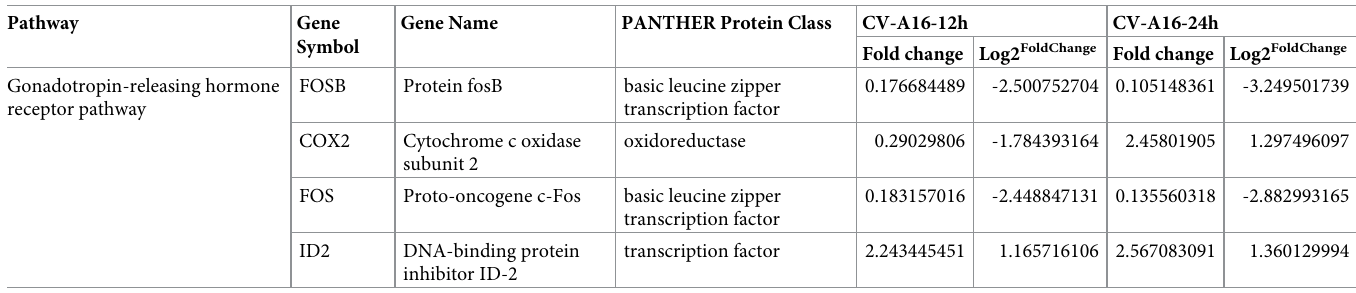
Table 3. Gonadotropin-releasing hormone receptor pathway-associated differentially expressed genes in KEGG pathway analysis.